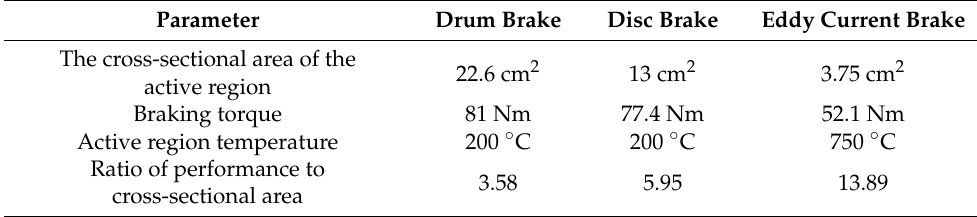
Table 1. Comparison of braking system properties. Parameter Drum